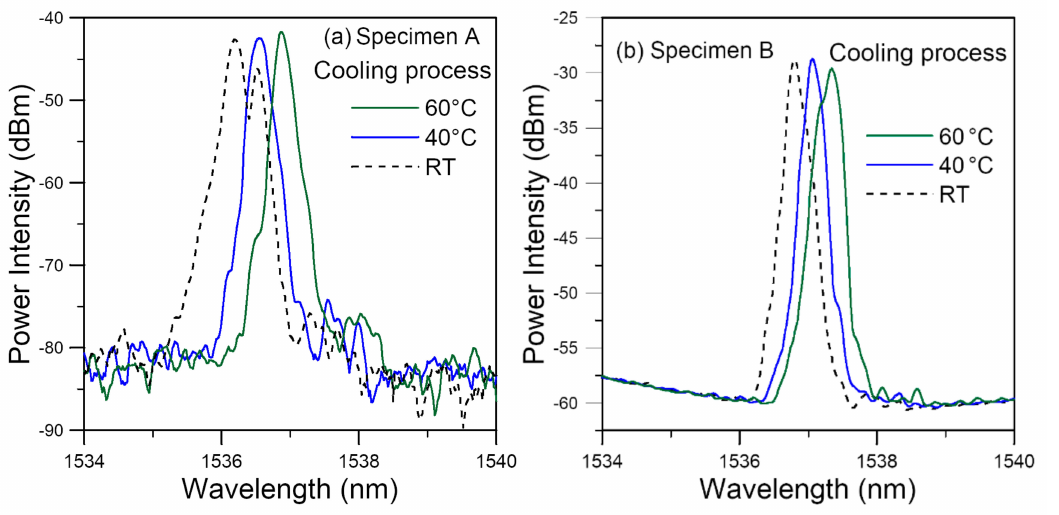
Figure 6. FBG spectra during the cooling process after soaking at 60 ◦ C for 30 days showing general shift to the left for specimens ( a ) A and ( b ) B.